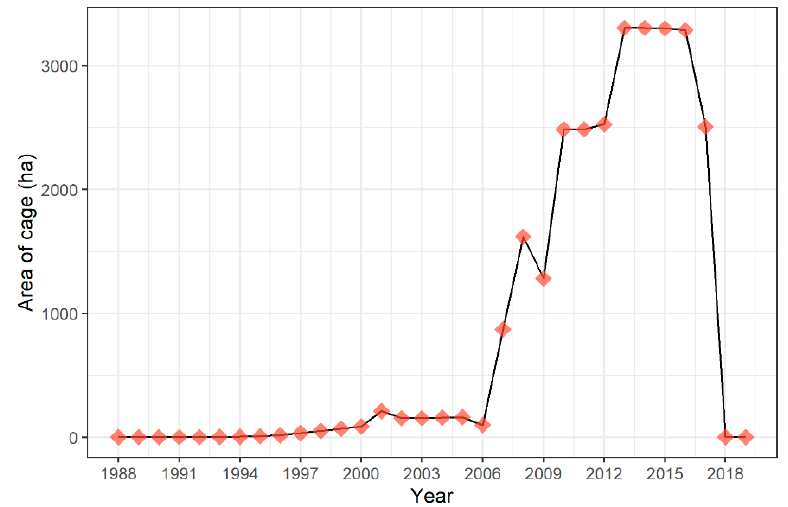
Figure 2. The area of cages for fish culture every year (1988–2019).